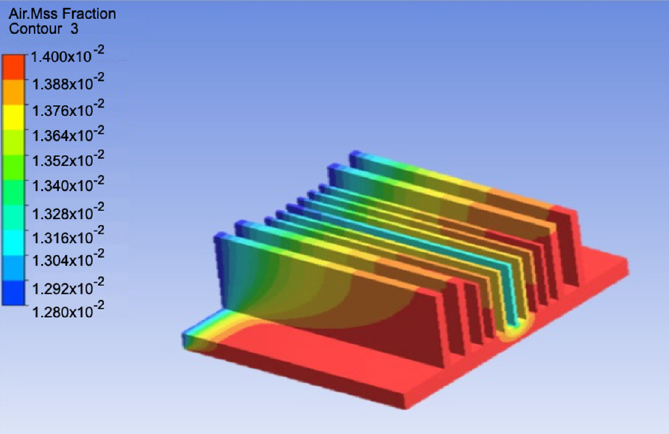
Figure 9. Mass fraction of air for the numerical model.